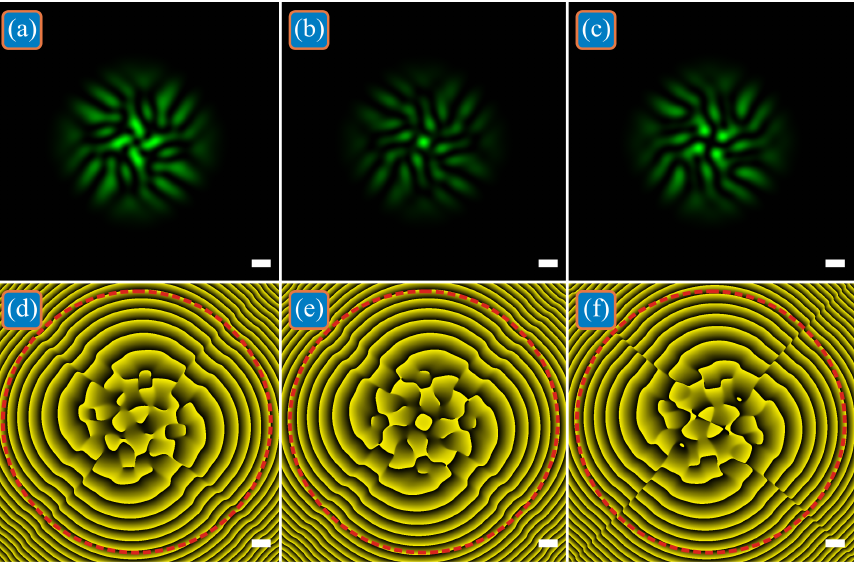
Figure 3. Intensities ( a – c ) and phases ( d – f ) of three superpositions of off-axis single-ring LG beams with the initial distribution shown in Figure 1 at triple Rayleigh distance (far zone). The total TC of the superpositions is the same as that of each constituent beam ( a , d ), or differs from the TC of each beam by +1 ( b , e ) and by −1( c , f ) due to the presence of complex weight coefficients in the superposition. It should be noted that all LG beams in the superpositions shown in Figures 1–3 have the same power. However, it follows from the theory above that if all superposition coefficients are real then the TC does not change even in the case of a superposition of LG